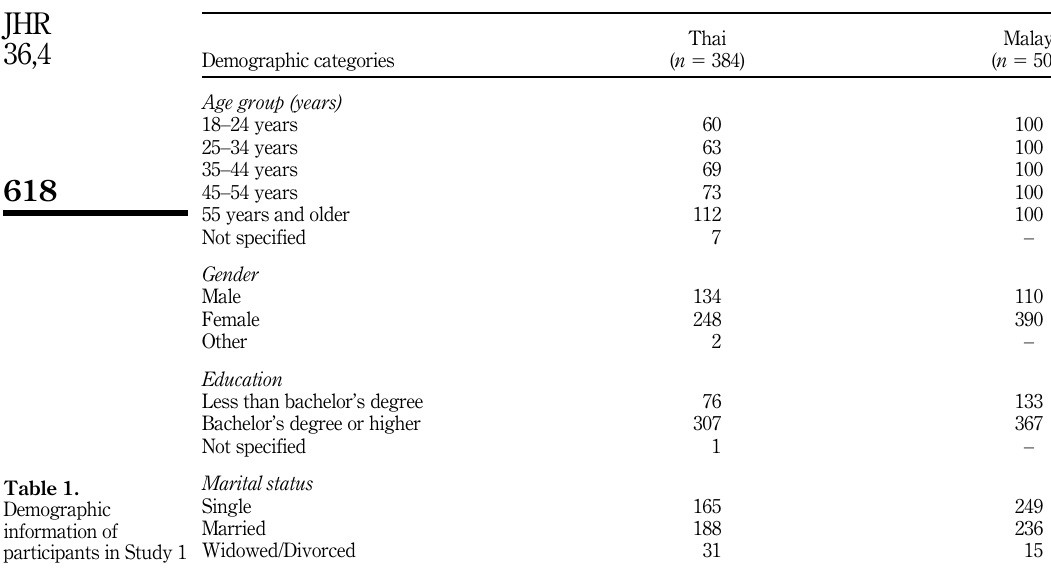
Table 1. Demographic information of participants in Study